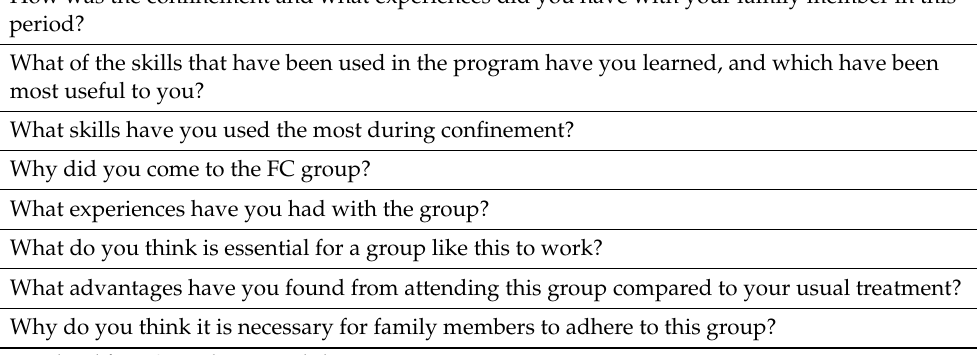
Table 1. Questions 1 addressed in the focus